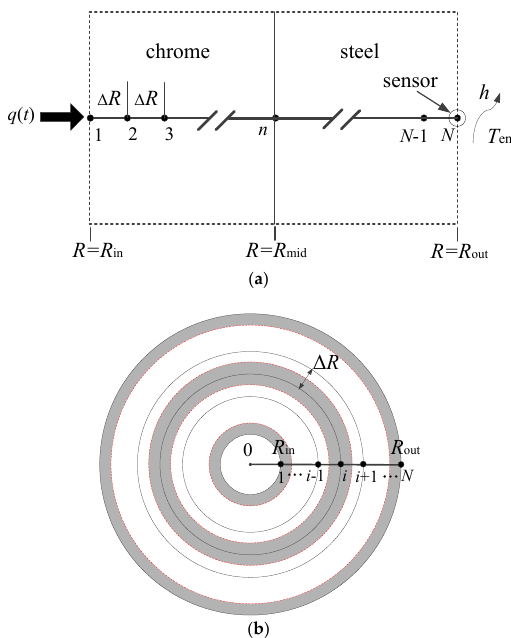
Figure 2. Schematic view of mesh configuration for a two-layer gun barrel: ( a ) Mesh of the geometry; and ( b ) control volume for each node.